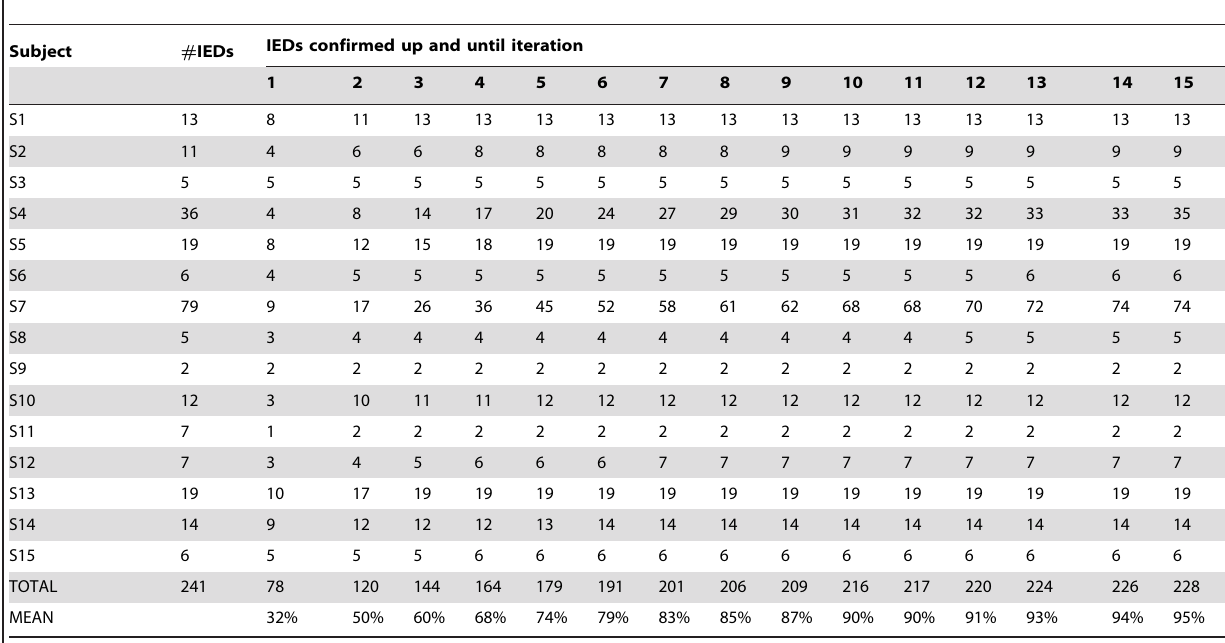
Table 2. Adaptive iterative reviewing: IED nominations are iteratively presented to the reviewer one-by-one using 10 events per iteration.